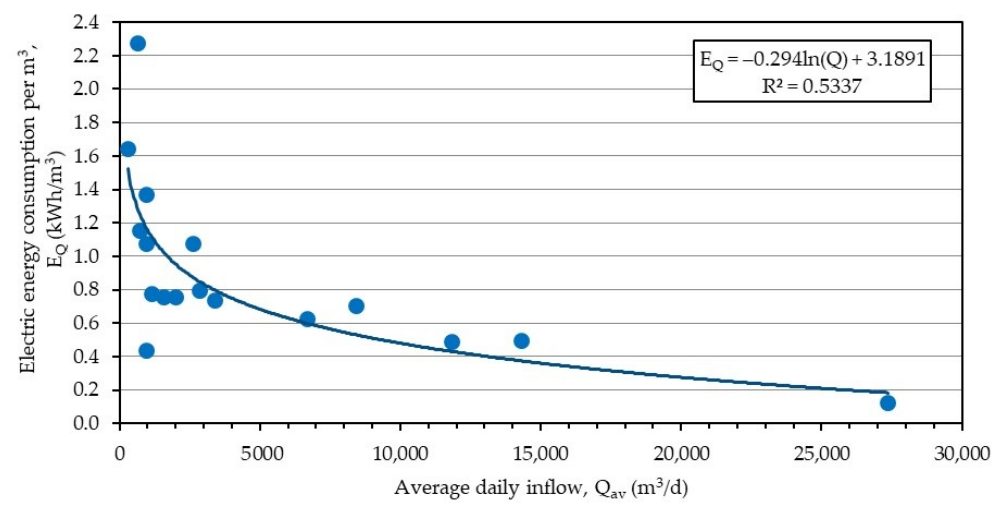
Figure 8. Blue points: electricity consumption, E Q (kWh/m 3 ) per unit volume of treated wastewater as a function of average daily wastewater flow, Q av (m 3 /d), for the 17 examined WWTPs; blue line: trend line E Q = − 0.294 ln (Q av ) + 3.1891 with R 2 = 0.5337.